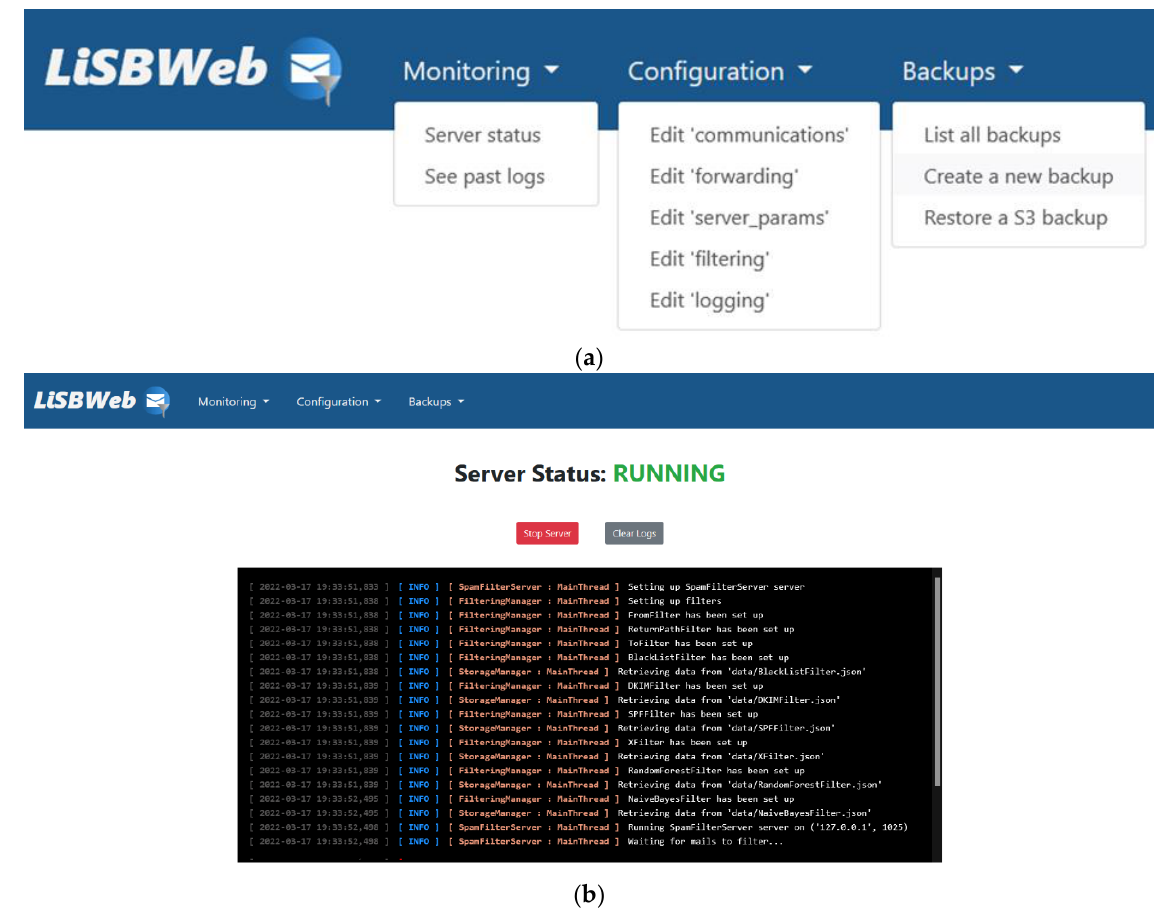
Figure 2. LiSB administration website: ( a ) LiSBWeb Menu; ( b ) LiSBWeb admin console.